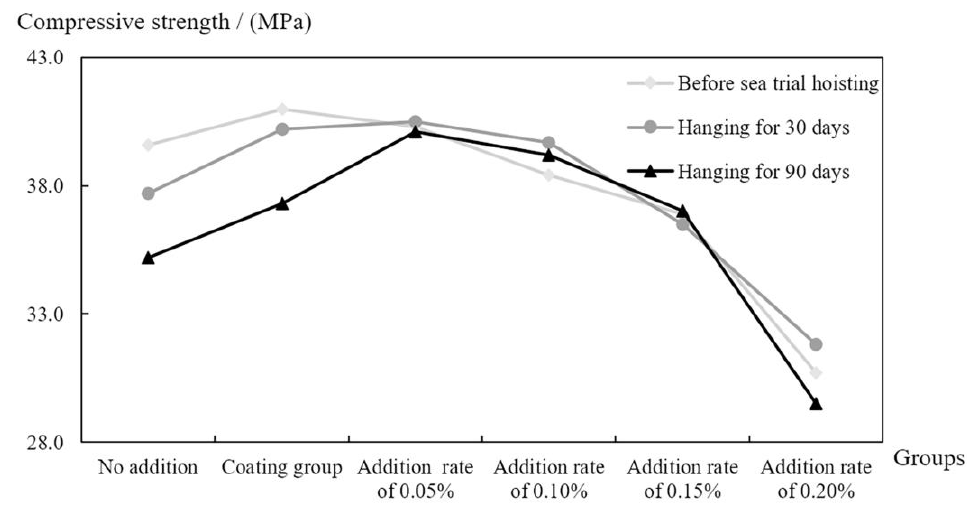
Figure 11. Folding line graph of changes in compressive strength before and after the sea experiments for each group.